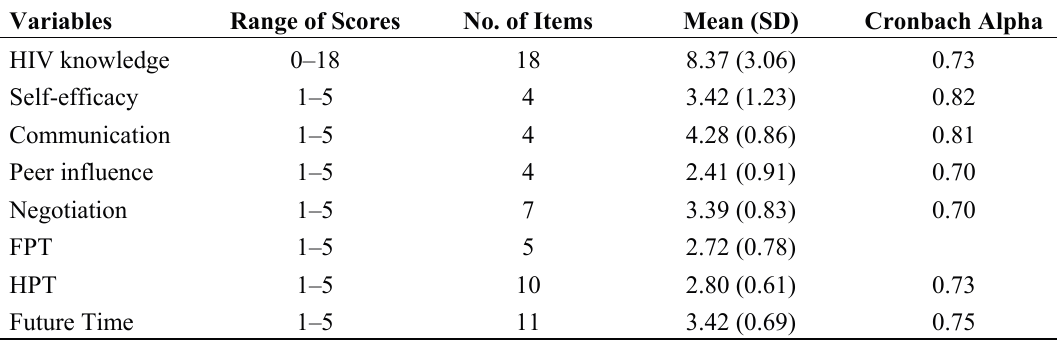
Table 1. Psychometric description of